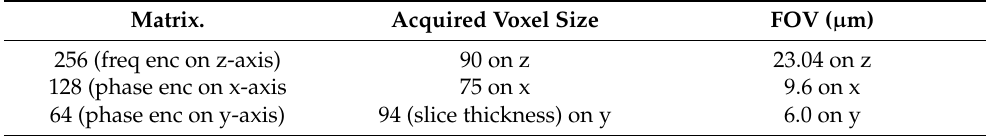
Table A3. 3D FLASH acquisition